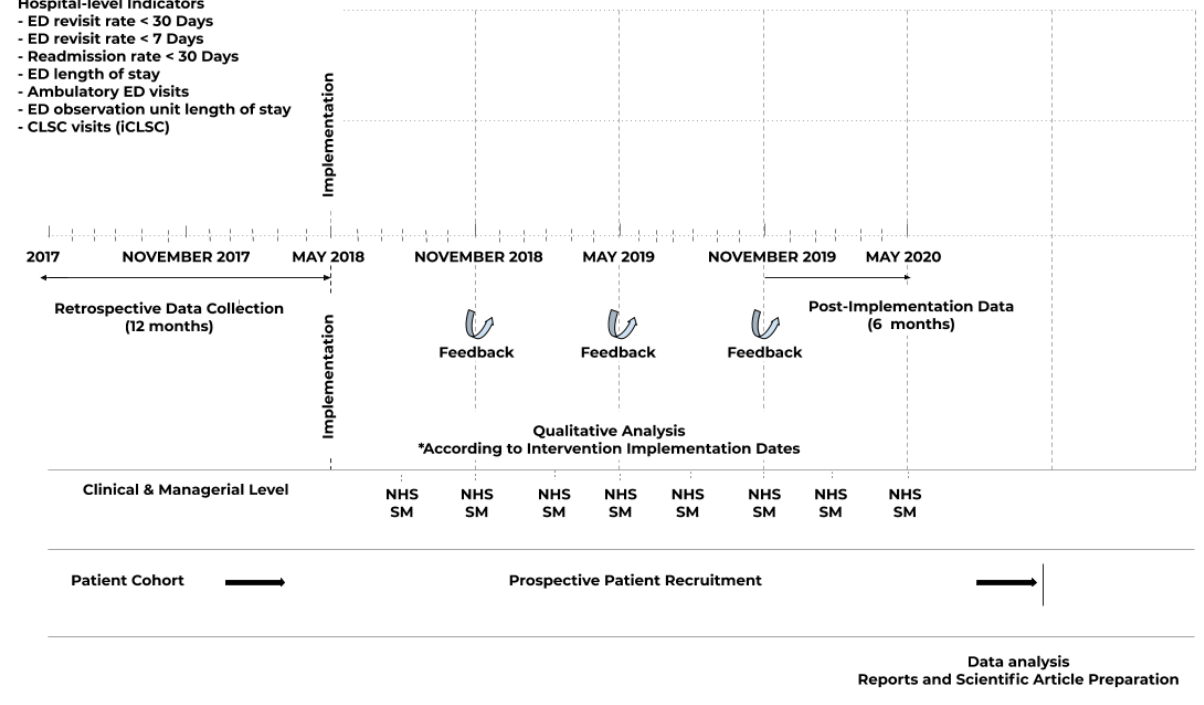
Figure 2. LEARNING WISDOM study design, data collection, indicators, and recruitment process. CLSC: Centres locaux de services communautaires (Local Community Services Centers); ED: emergency department; NHS SM: National Health Service Sustainability